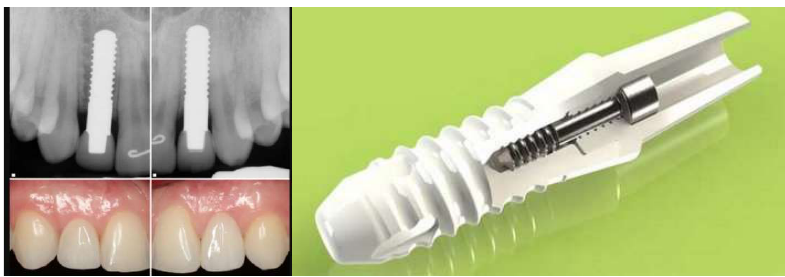
Fig. 1. Implants made by the zirconium